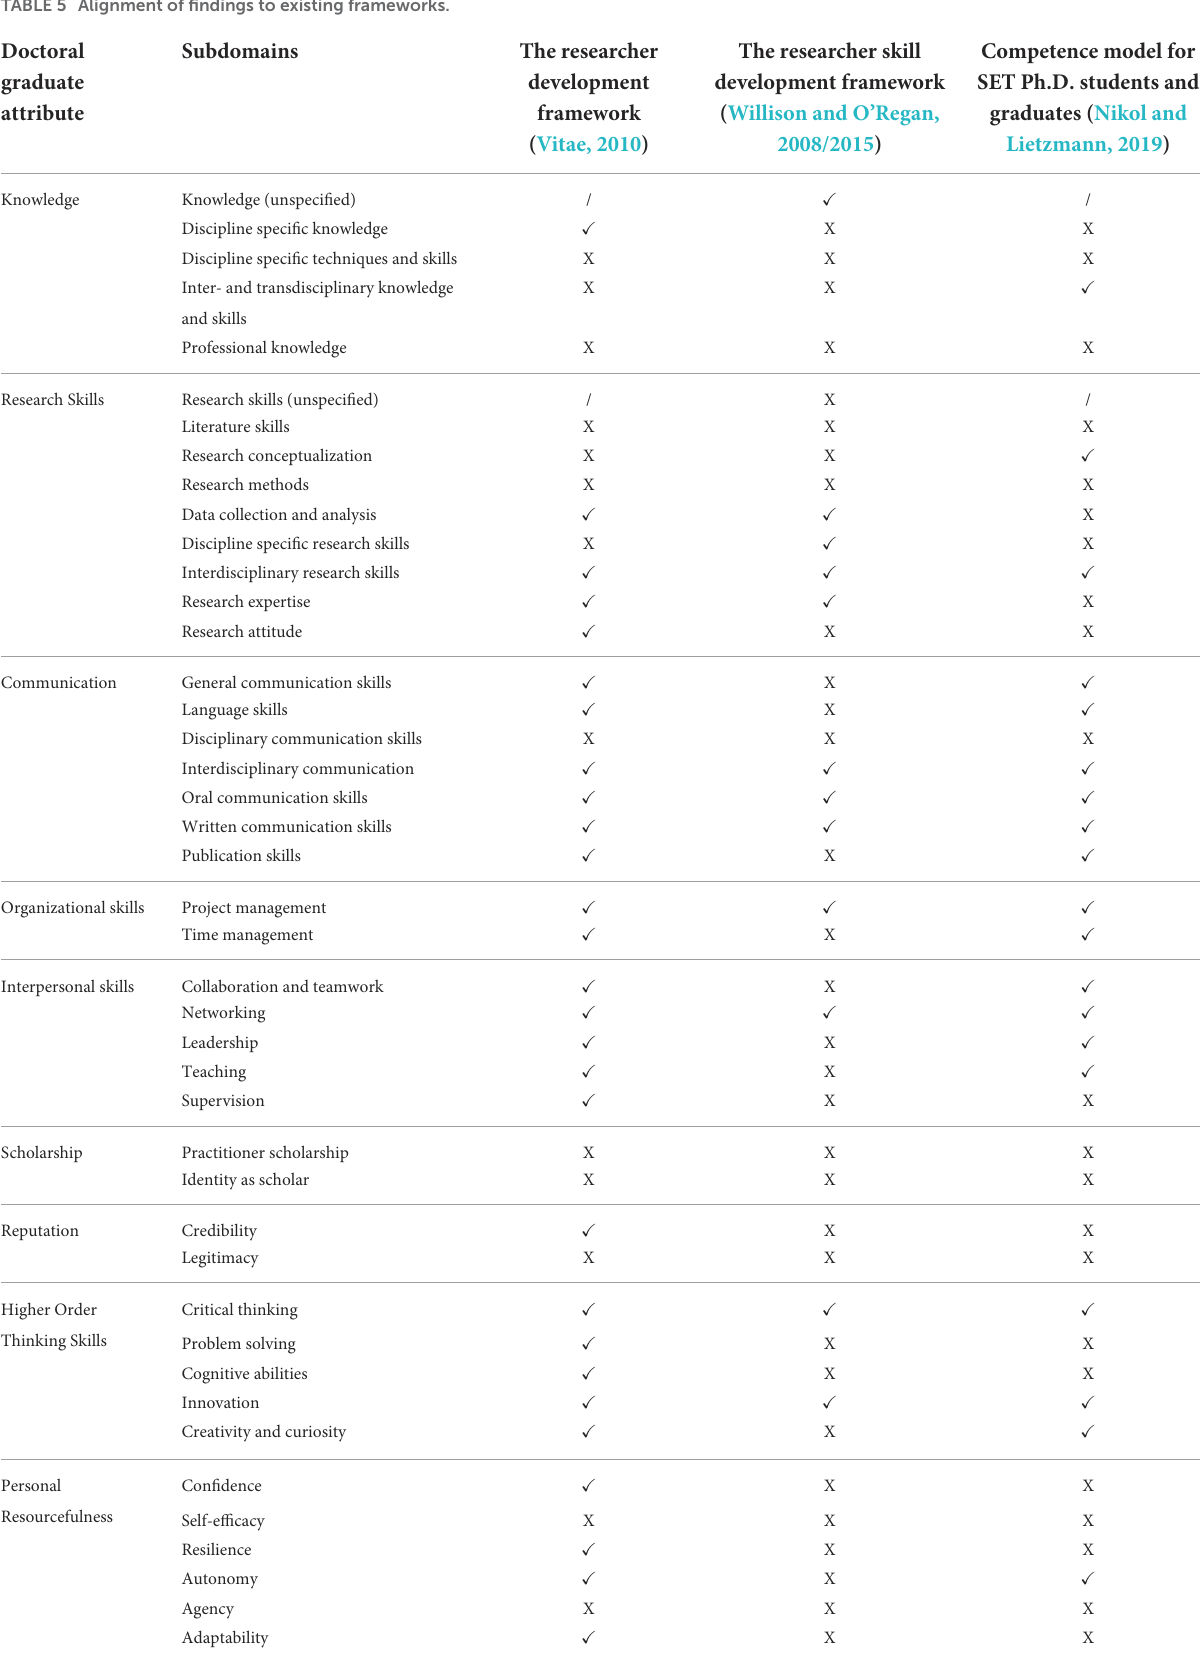
TABLE 5 Alignment of findings to existing